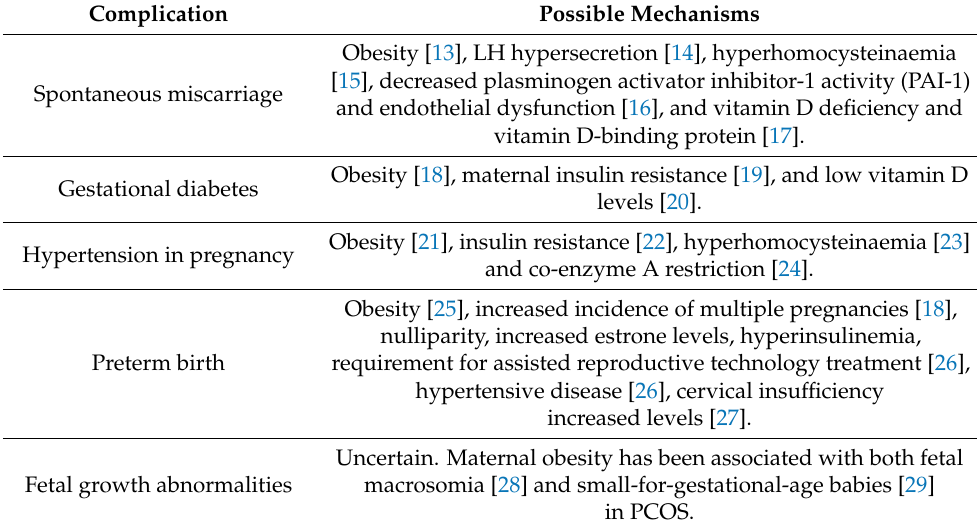
Table 1. Potential pregnancy complications in PCOS and possible mechanisms. Complication Possible Mechanisms